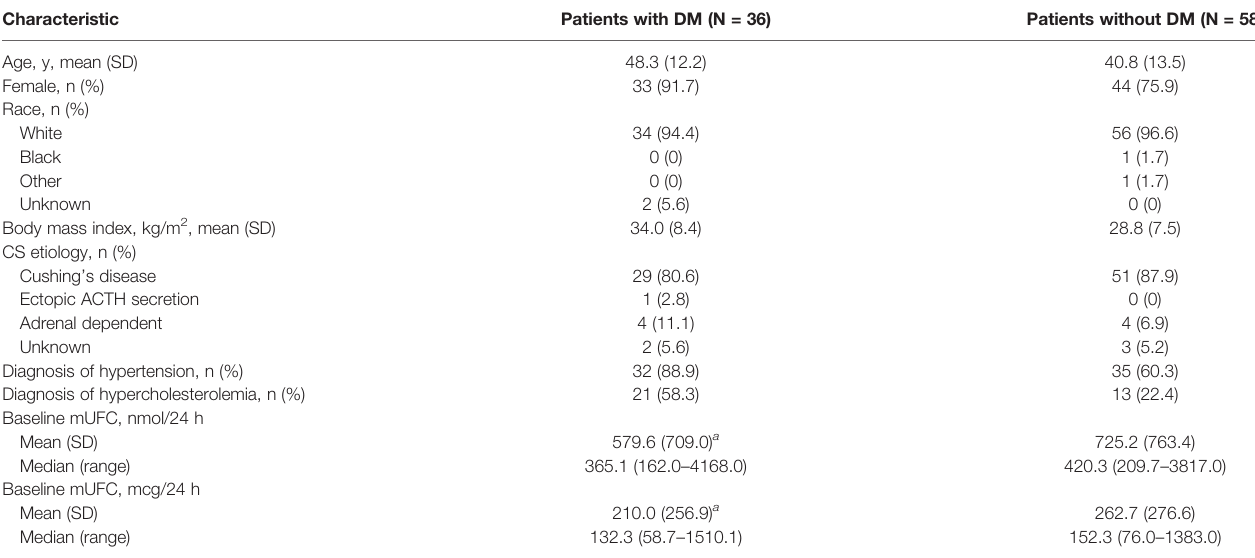
TABLE 1 | Patient demographics and baseline characteristics (ITT